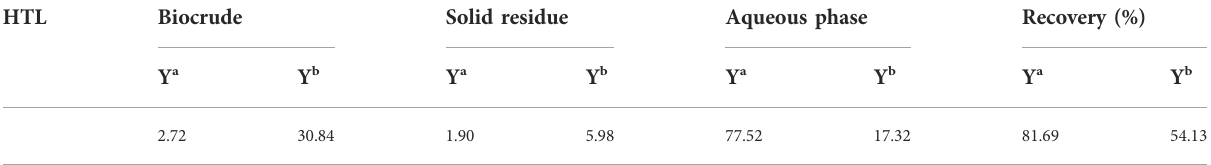
TABLE 2 Mass balance and yields (wt%) of products from continuous process at 350 ° C with 8 min retention time. HTL